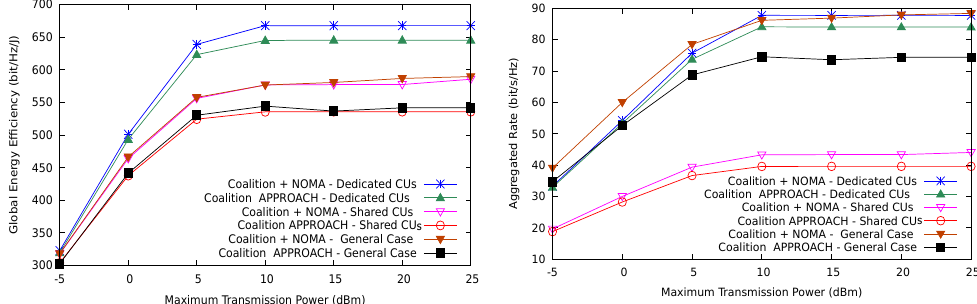
Figure 3. Global energy efficiency and aggregated rate using KNN